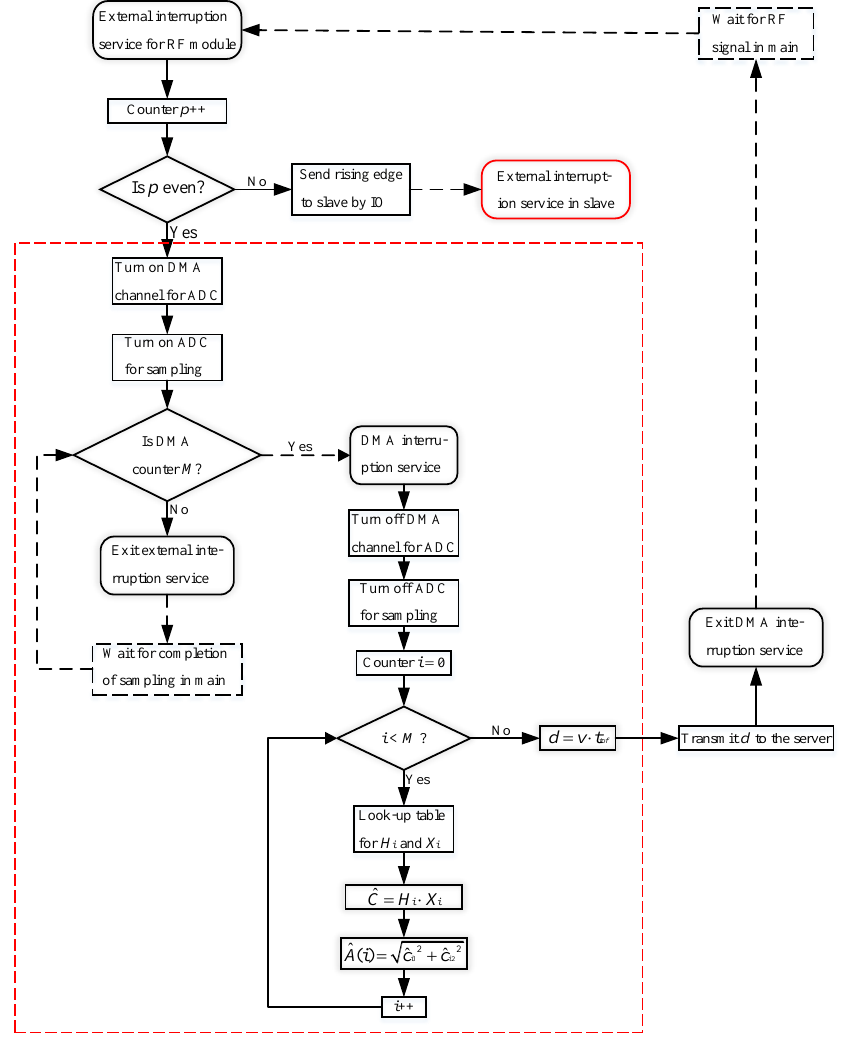
Figure 9. The software architecture and flow diagram of the UIPS receive node. DMA: direct memory access. IO: